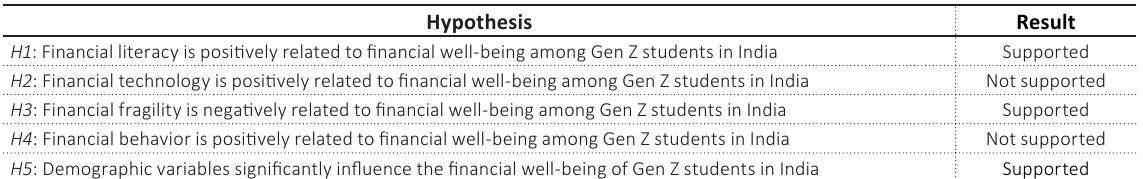
Table 17. Hypothesis